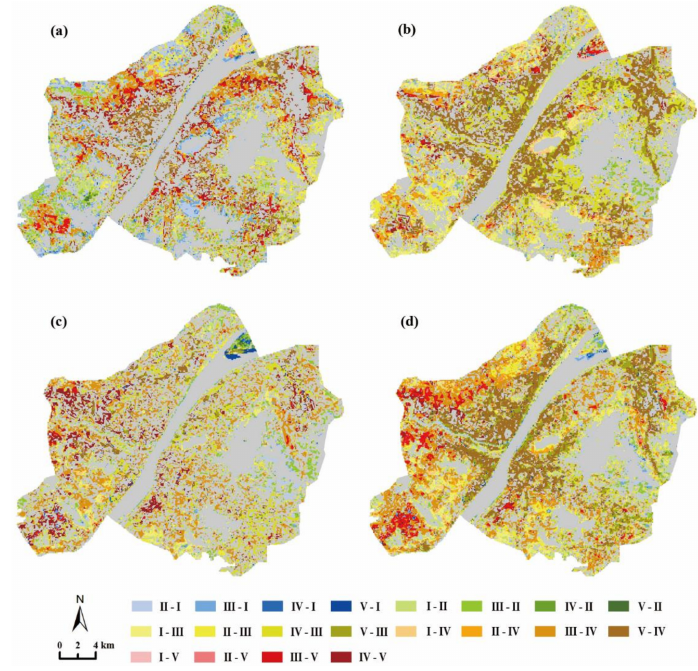
Figure 3. NLST variation maps during 1987–1996 ( a ), 1996–2007 ( b ), 2007–2016 ( c ) and 1987–2016 ( d